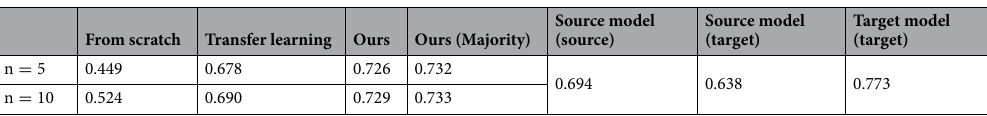
Table 3. Results (DSC) for the pancreas CT